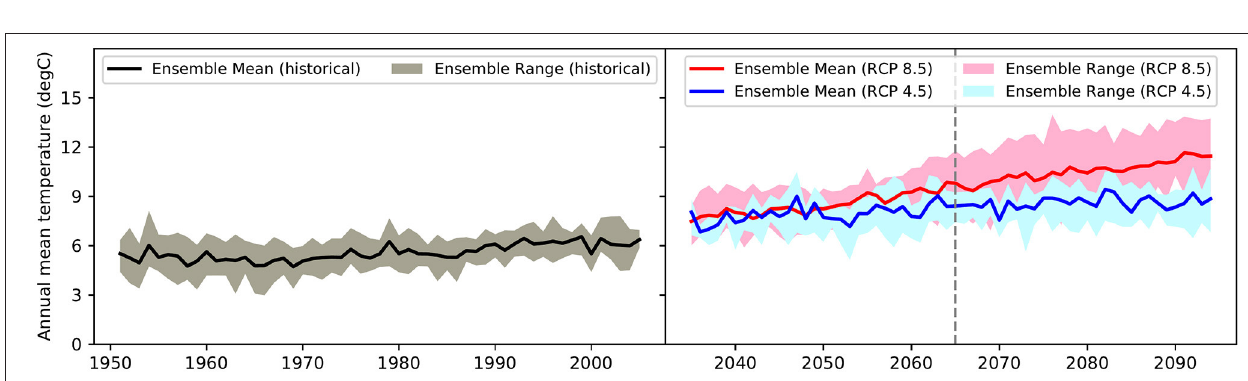
FIGURE 6 | Time series of GL basin annual mean temperature in historical (1951–2005) and future (mid-century: 2035–2064 and end-century: 2065–2094) periods for two emission scenarios (RCP4.5 and